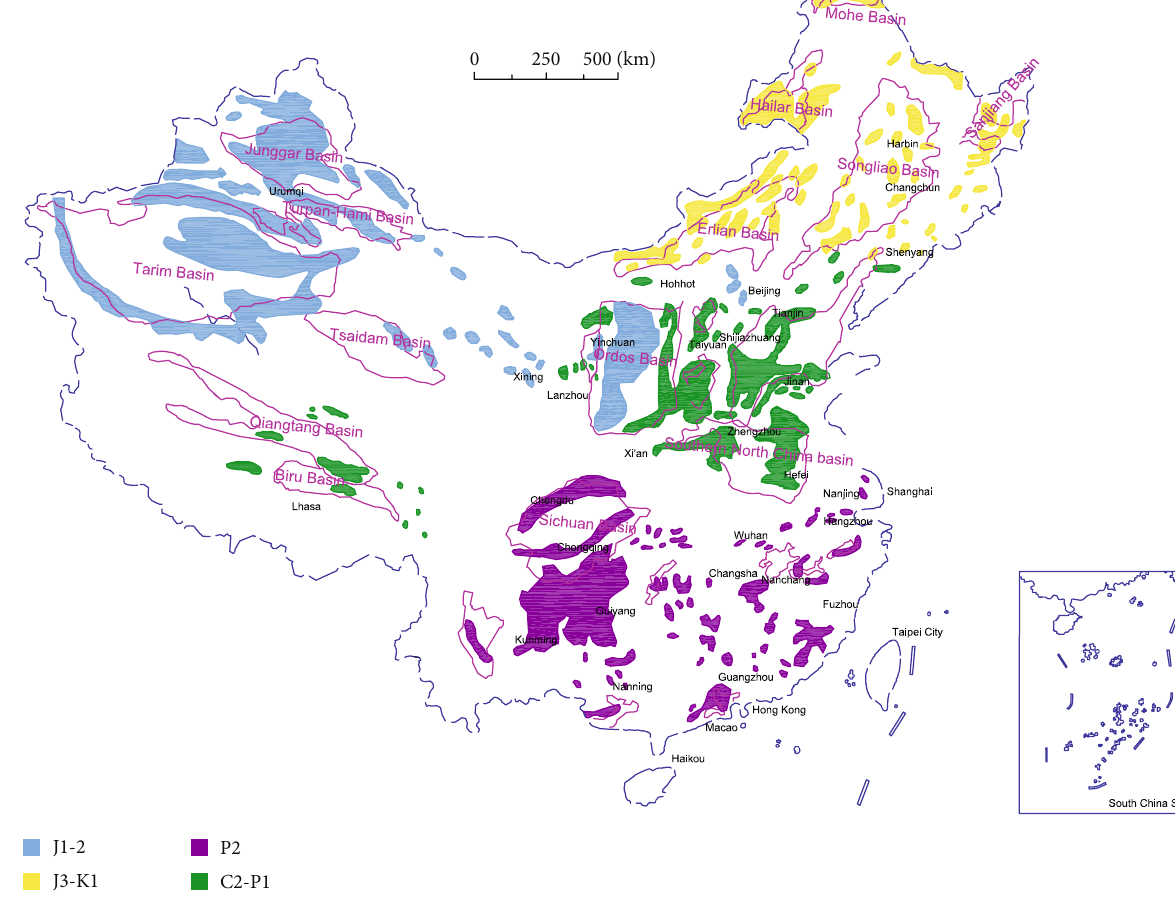
Figure 1: Coal-bearing basins in